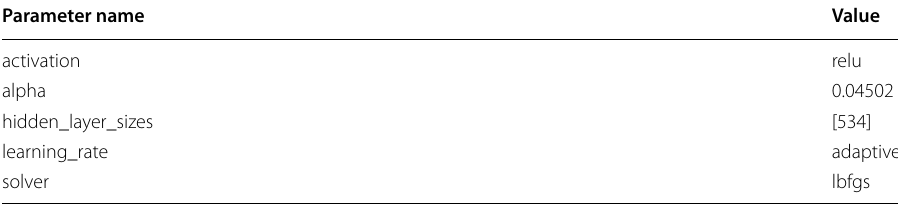
Table 92 Modes of MLP tuned hyperparameter values for experiments with the data exfiltration